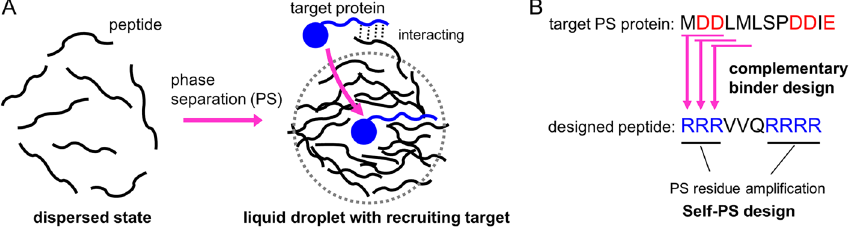
Figure 1. Design concept of artificial PS peptide. ( A ) Liquid droplet formation of PS peptide and recruitment of a target protein. Peptides (black) dispersed in solution form a liquid droplet, and the target protein (blue) is recruited into the droplet. ( B ) Scheme of one-by-three design targeting PS protein sequence (pink arrow). This provides the complementary peptide binder sequence and PS residue amplification in the peptide (e.g. 7 R in peptide vs. 4 D plus 1 E in target) for self-PS. p53 N-terminal IDR sequence is displayed as an example of target PS protein. Red and blue characters of sequences correspond to PS